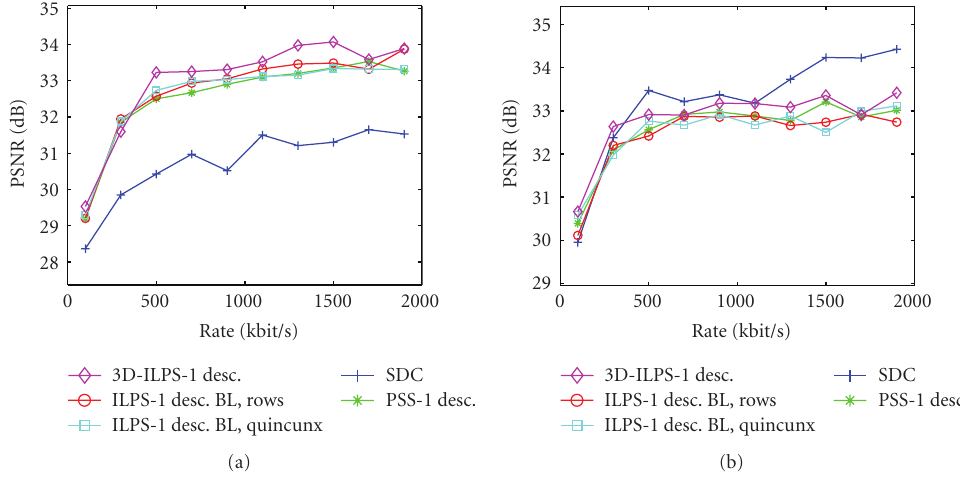
Figure 13: Performance of left view, one subsequence received, 10% packet loss. (a) Breakdance. (b)